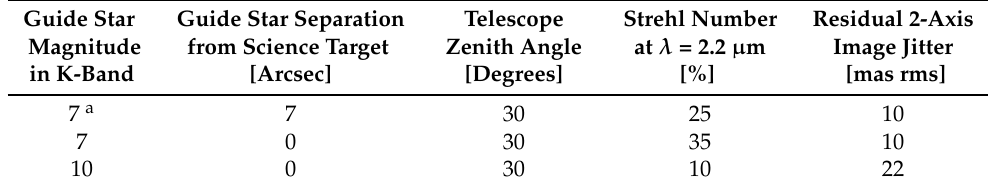
Table 1. Performance requirements for Coudé Infrared Adaptive Optics (CIAO) under